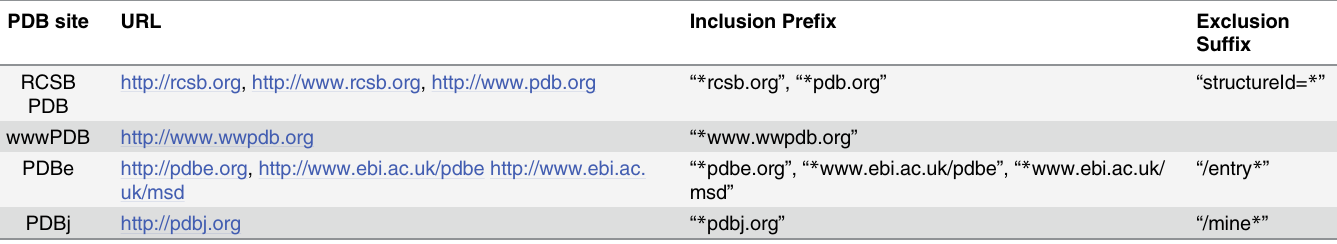
Table 1. Text patterns considered as PDB